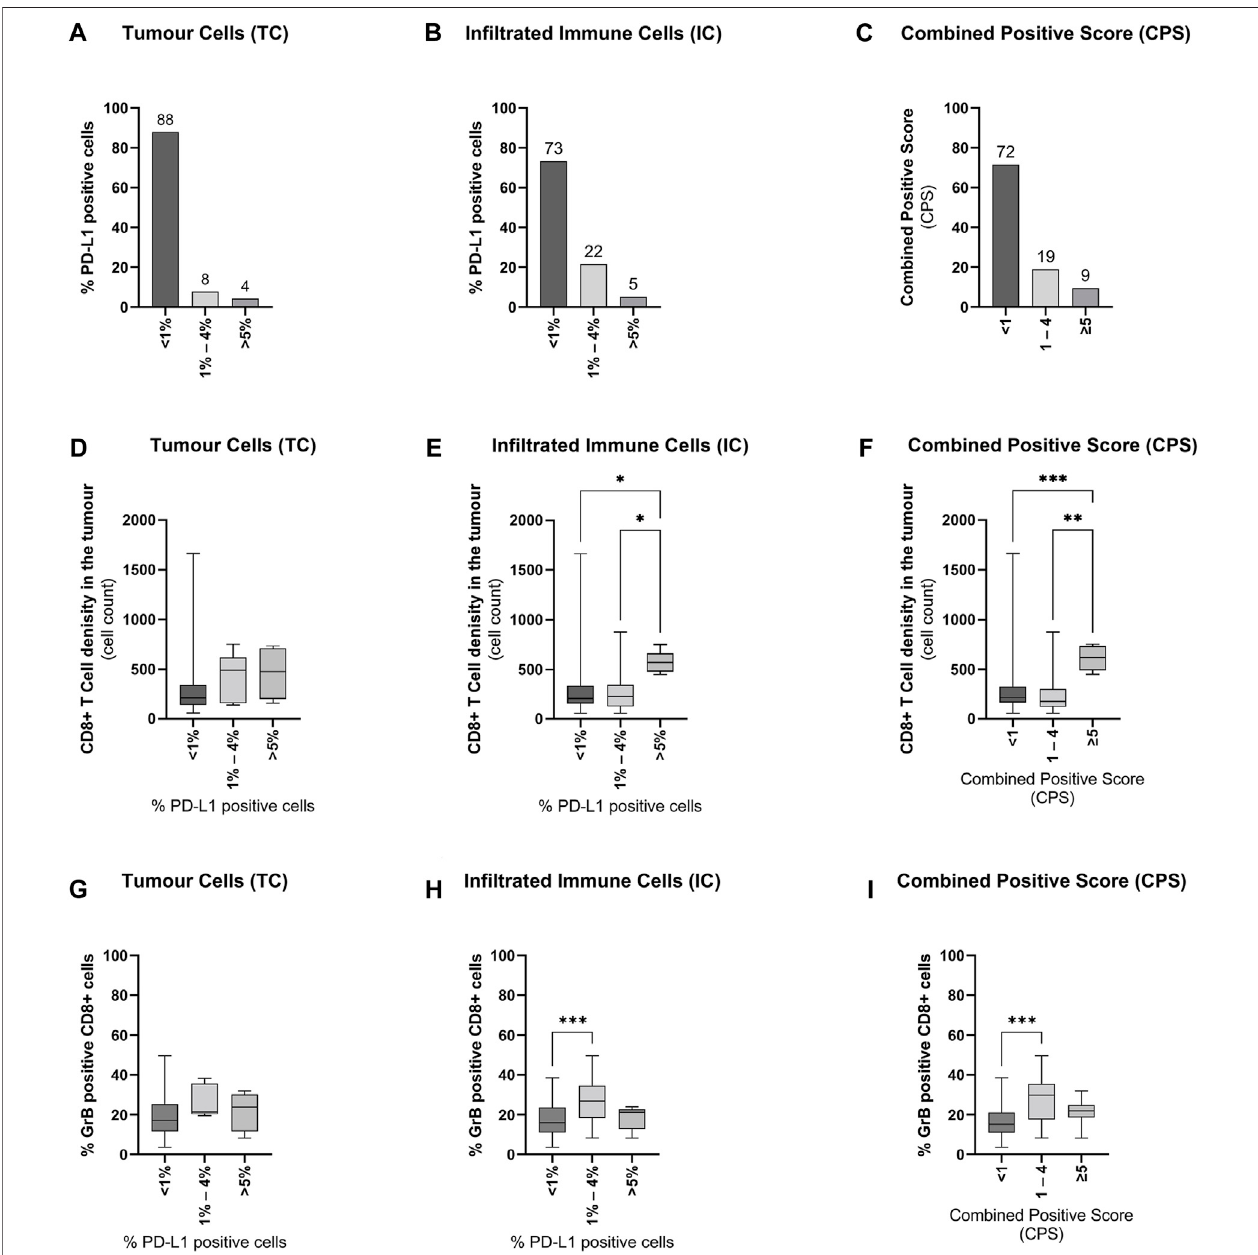
FIGURE2| In fl uenceofPD-L1expressiononCD8 + T-cellin fi ltrationandactivityinprimaryprostatecancertissue(A+B+C)Graphicalillustrationofthedistribution of PD-L1 expression on (A) tumour cells, (B) in fi ltrating immune cells, and the resulting combined positive score (CPS) in all examined tissue specimens ( n = 116). Numbersaredisplayedascolumnbarblots.(D+E+F)GraphicalillustrationoftheassociationsofCD8 + T-cellsin fi ltrationwith (D) PD-L1expressionontumourcells, (E) PD-L1 expression on tumour-in fi ltrating immune, and (F) the combined positive score in all examined tissue specimens ( n = 116). Values are expressed as Box WhiskerPlot(mintomax).(G+H+I)GraphicalillustrationoftheassociationsofCD8 + T-cellsactivitywith (G) PD-L1expressionontumourcells, (H) PD-L1expressionon tumour-in fi ltratingimmunecells, and (I) thecombinedpositivescore in all examined tissue specimens ( n =116). Values are expressed as BoxWhisker Plot (min tomax). All differences highlighted by asterisks were statistically signi fi cant (*: p ≤ 0.05; **: p ≤ 0.01; *** p ≤ 0.001).